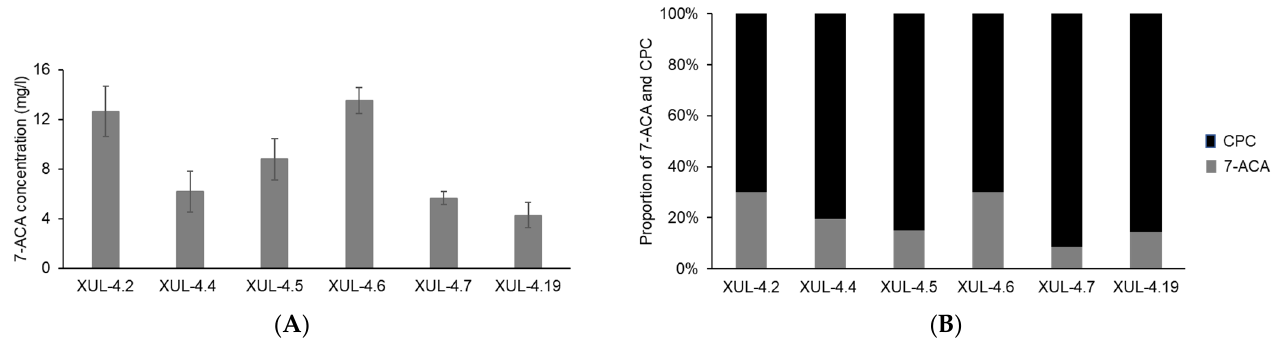
Figure 9. 7-ACA yield and the conversion rate of CCAA transformants after incubating at optimal reaction conditions. The supernatants of CCAA transformants were isolated after 72 h of culture and the pH was adjusted to 9.5. HPLC analyses were performed with samples collected after 48 h of incubation at 12 °C. ( A ) The concentration of CCA product 7-ACA was calculated according to the calibration curve (Figure S6A). ( B ) The proportion of the concentration of 7-ACA and CPC after enzyme reaction represents the conversion rate of CCA. The concentration of CPC was calculated using the reference calibration curve (Figures S6B and S7).